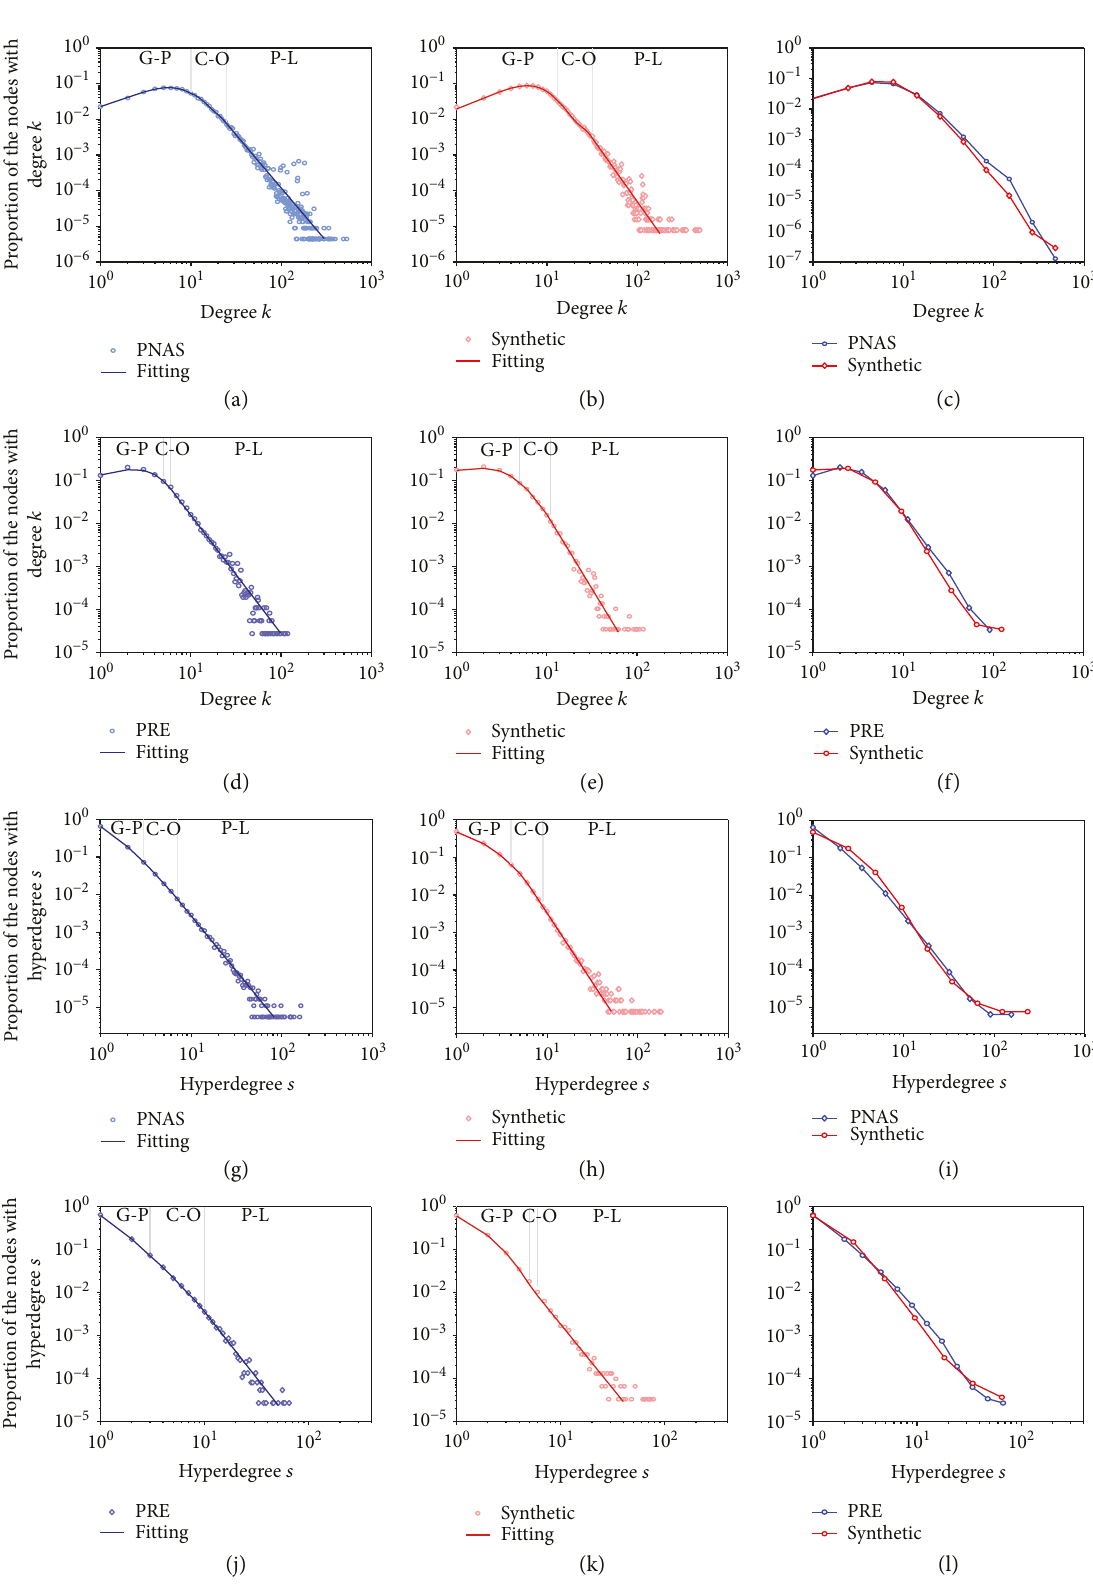
Figure 2: The empirical and synthetic distributions of collaborators/papers per author. The regions “ G-P, ” “ C-O, ” and “ P-L ” stand for generalized Poisson, crossover and power law, respectively. The parameters and goodness of fi ttings are listed in Table